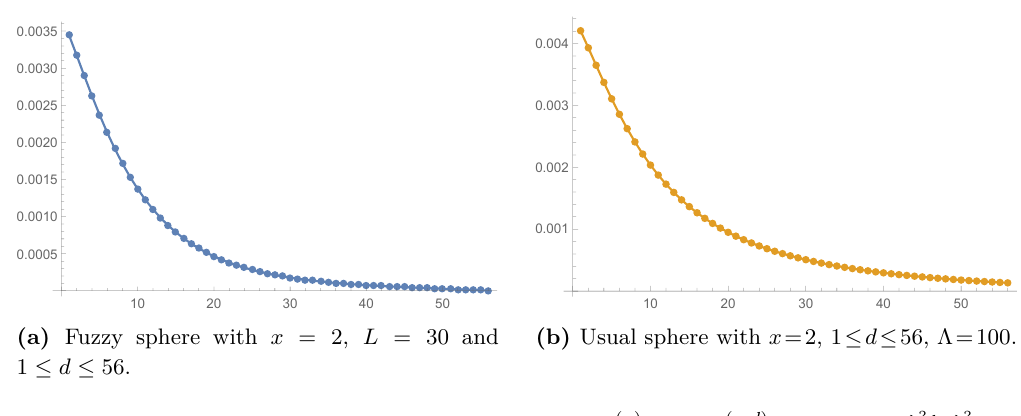
Figure 9 . The mutual information I ( x, y ; d ) between H ( x ) horizontal axis is d . x = 2 , R = 1 and µ = 10 . The cutoff are 2 L = 60 for the fuzzy sphere case (a) and Λ = 100 for the usual